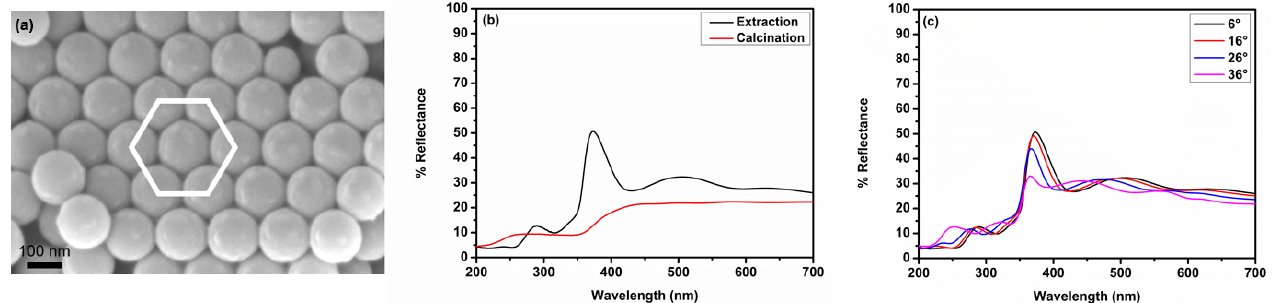
Figure 6. ( a ) SEM micrograph of PS-175T assembled using convective assembly showing the face-centered cubic arrangement of the particles. ( b ) Reflectance spectra of ZnO IOs obtained after five mineralization cycles using different methods for removal of the sacrificial PS particles and ( c ) Reflectance spectra of ZnO IOs (extracted) measured at different angles of incidence.